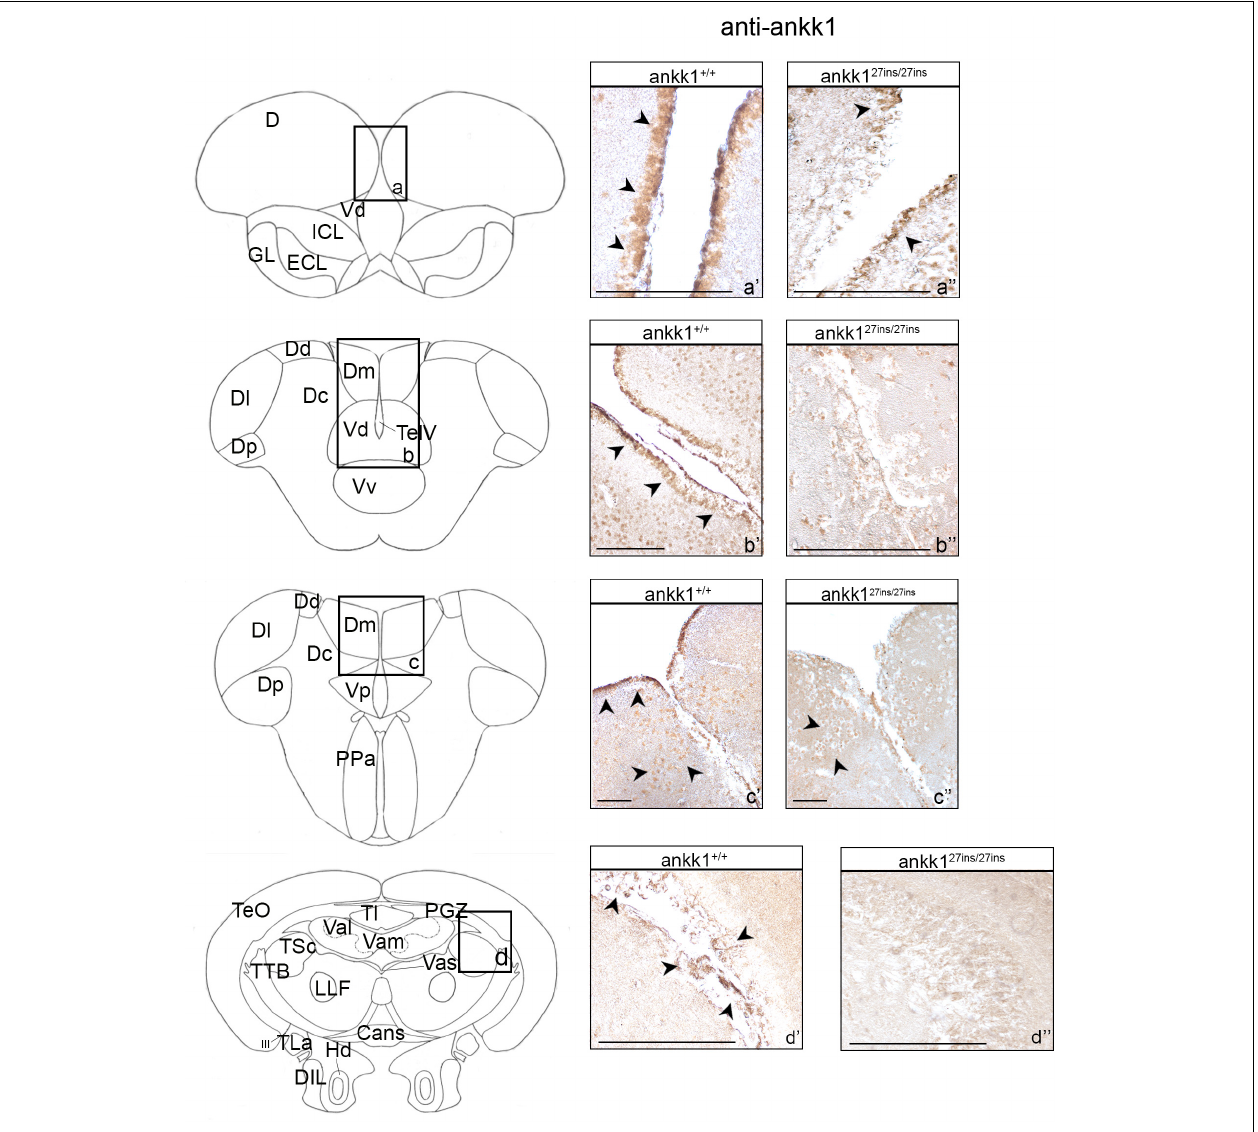
FIGURE 3 | Ankk1 immunohistochemistry in adult zebrafish brain. On the right, ankk1 protein distribution in transverse sections of adult zebrafish brain, ankk1 + / + and ankk1 27 ins / 27 ins . On the left, schematic depiction of zebrafish brain, transverse section [adapted from Wullimann et al. (1996)]. (a–d) Boxes on the schematic depictions represent the region of the brain showed by the corresponding immunohistochemistry on the right; (a’–c”) forebrain ankk1 staining; (d’,d”) ; midbrain ankk1 staining. Scale bars: (c’,c”) , 50 mm; (b’) , 100 mm; (a’,a”,b”,d’,d”) , 200 mm. Arrows indicate anti-ankk1 positive